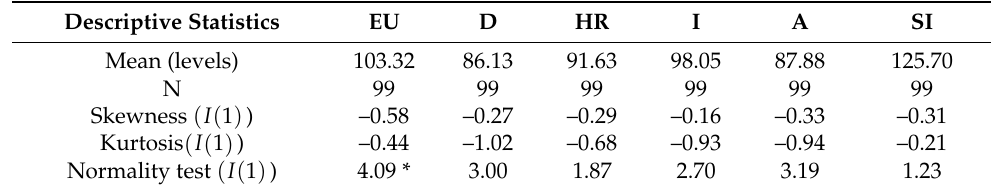
Figure A3. ( a ) Distribution of price indices in the hospitality industry for Austria, Croatia, Germany, Italy, and Slovenia; ( b ) Distribution of I ( 1 ) price indices in the hospitality industry for Austria, Croatia, Germany, Italy, and Slovenia. Note. IPHI—Price index in the hospitality industry; EU—Eurozone; D—Germany, HR—Croatia, I—Italy, A—Austria, and SI—Slovenia. Data vector January 2012 to March 2020 (expansion period); d— I ( 1 ) . Table A3. Descriptive statistics of consumer price indices (base 2015), data vector 2012–2020. Descriptive Statistics